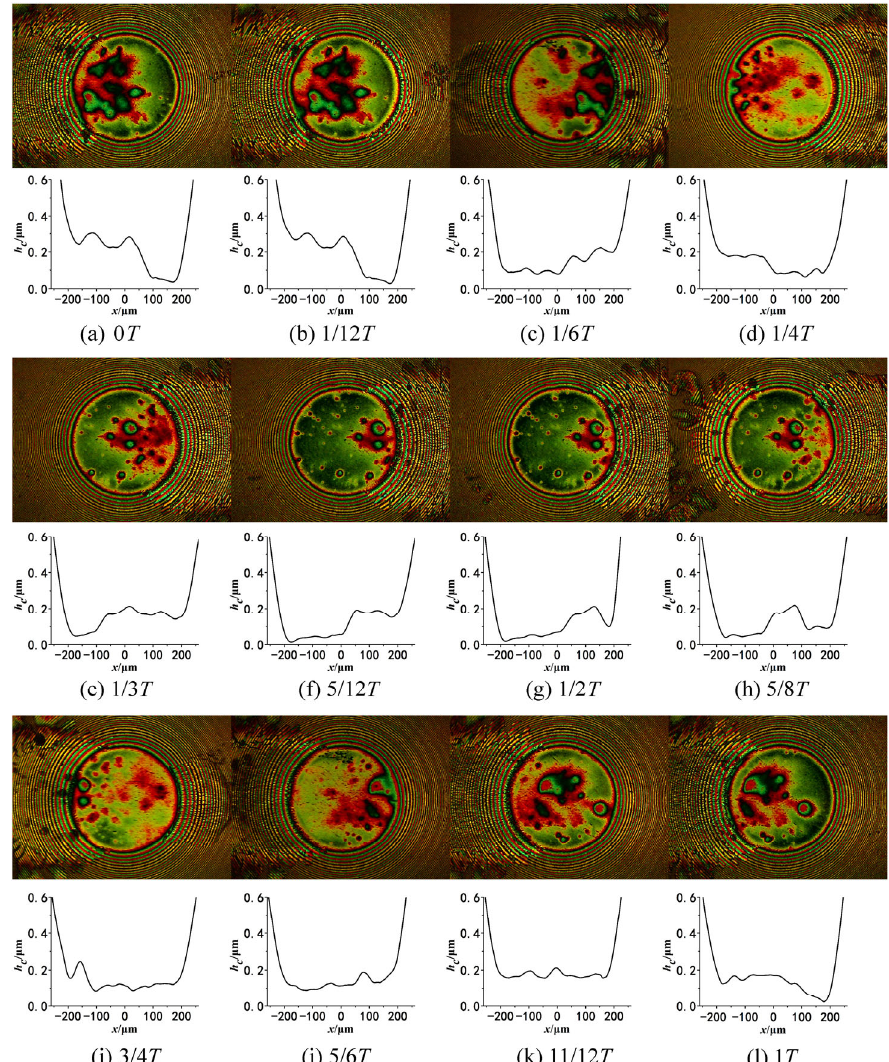
Fig. 11 Interferograms and midsection film thickness during 5th cycle under pure rolling reciprocating motion ( v max = 0.01 m/s, w = 50 N, T = 0.5 s, L = 1.25